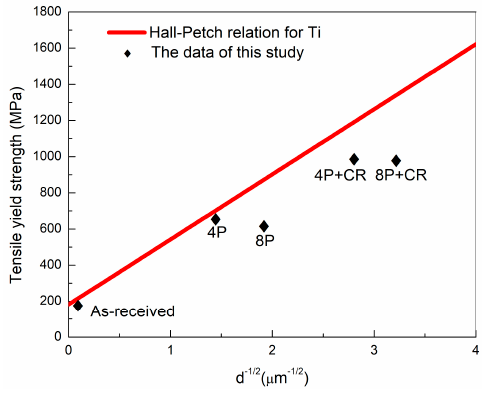
Figure 10. The Hall-Petch relation for Ti and the data of this study.